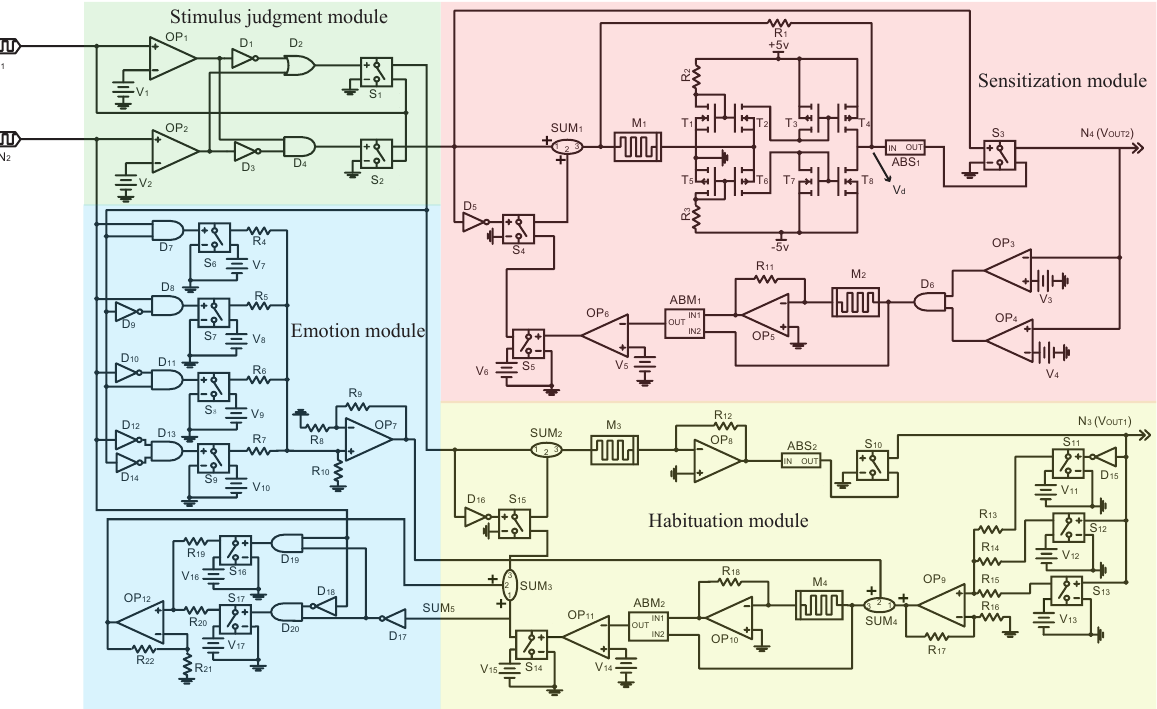
Figure 9. Complete